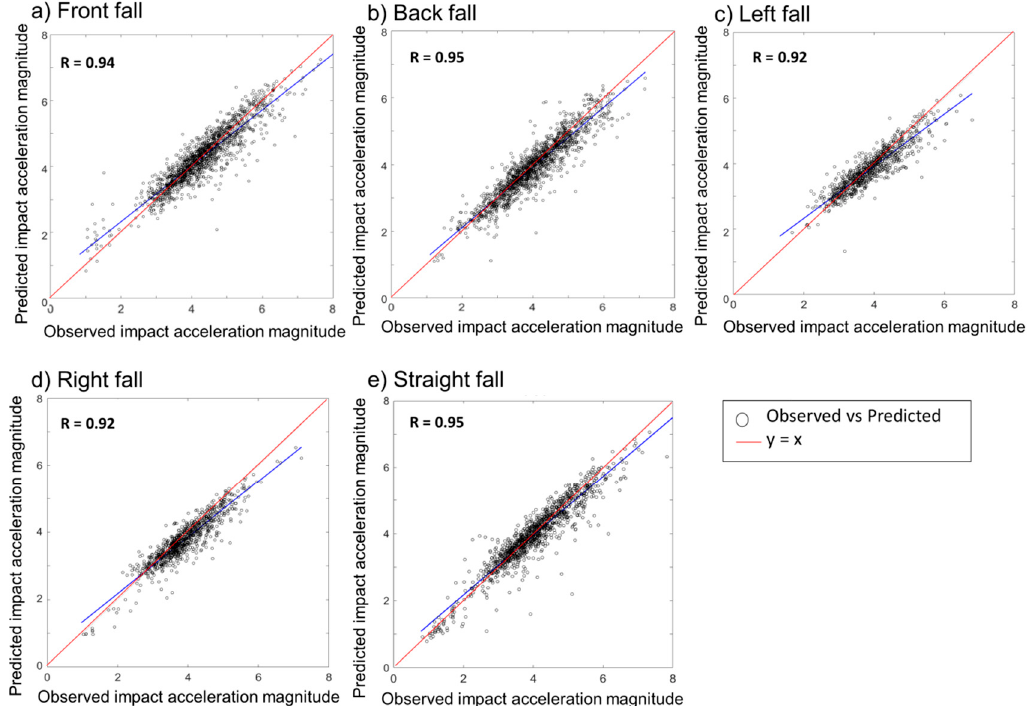
Figure 7. Regression analysis of pre-impact fall impact acceleration magnitude prediction at different directions. ( a ) the regression analysis of impact acceleration prediction for forward fall; ( b ) the regression analysis of impact acceleration prediction for backward fall; ( c ) the regression analysis of impact acceleration prediction for leftward fall; ( d ) the regression analysis of impact acceleration prediction for rightward fall; ( e ) the regression analysis of impact acceleration prediction for straight fall.